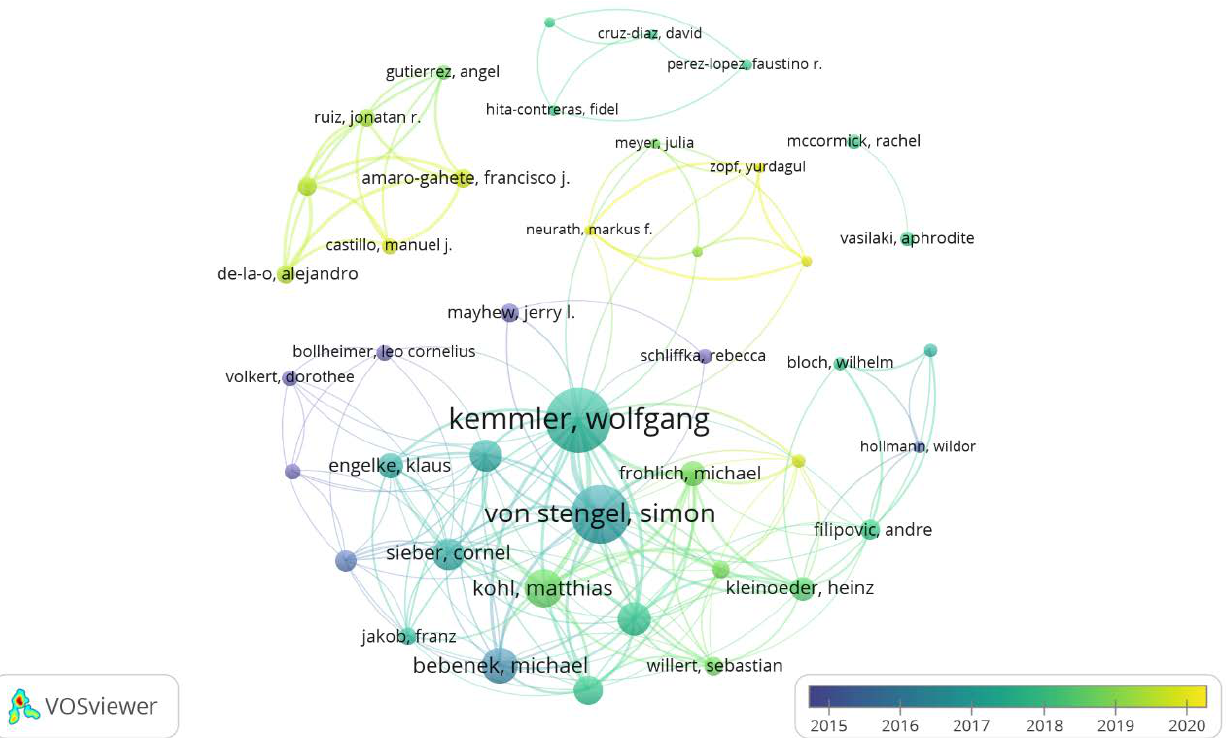
Figure 7. Author with more citations on WB-EMS.